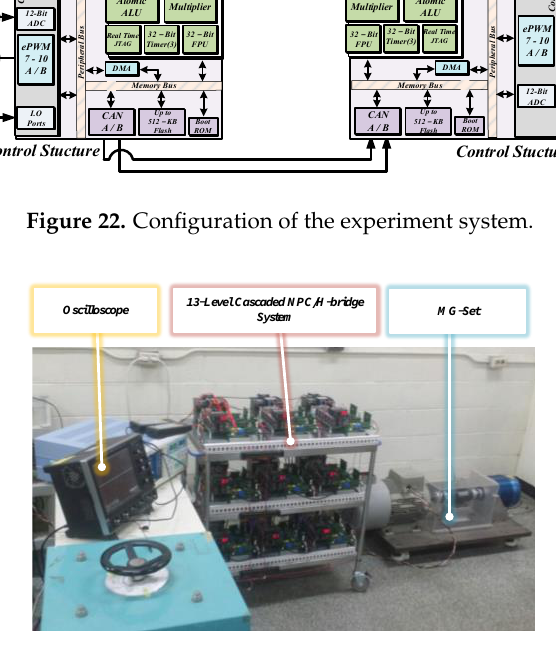
Figure 23. Experimental setup 1 of the 13-level cascaded NPC/H-bridge system.